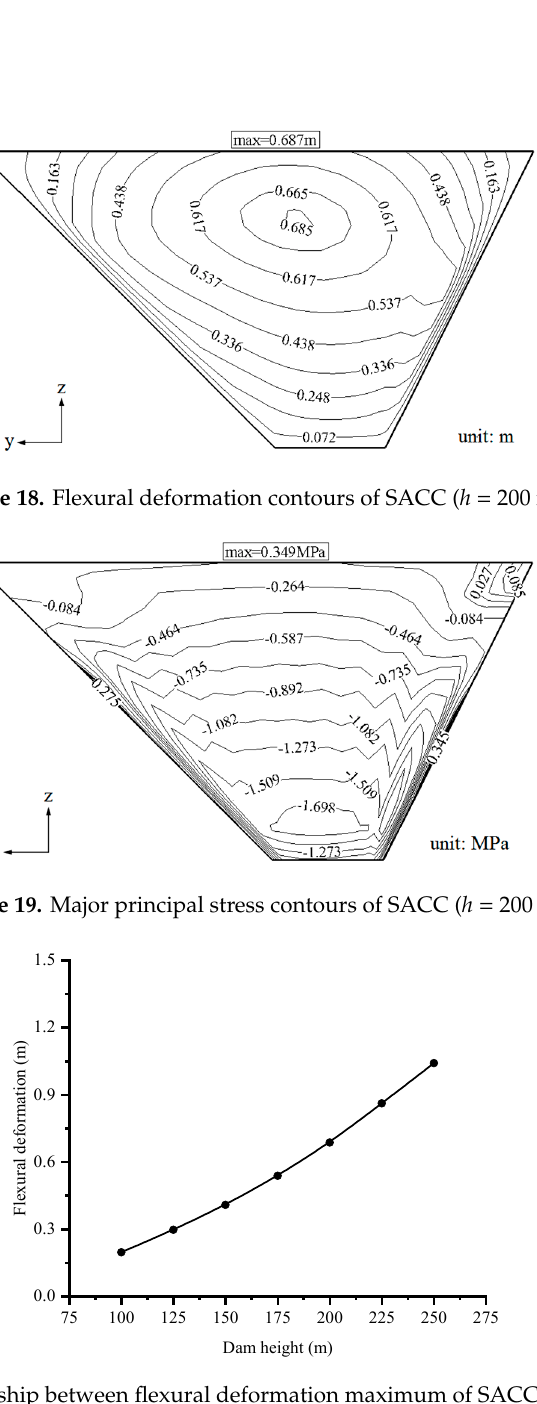
Figure 22. Relationship between tensile stress area maximum of SACC and dam height. Figures 23–25 and Table 8 show that the flexural deformation of SACC deceases with valley slope ratio and the tensile stress and tensile stress area of SACC increases sharply with valley slope ratio. When the valley slope ratio is 0.5:1.0, the flexural deformation of SACC is 0.750 m. The tensile stress of SACC is 0.126 MPa (the tensile safety factor is 2.38), which is far more than the YTFCS. The SACC is safe and will not experience tensile failure. The tensile stress area of SACC is 1013 m 2 . When the valley slope ratio is 2.5:1.0, the flexural deformation of SACC is 0.640 m. The tensile stress of